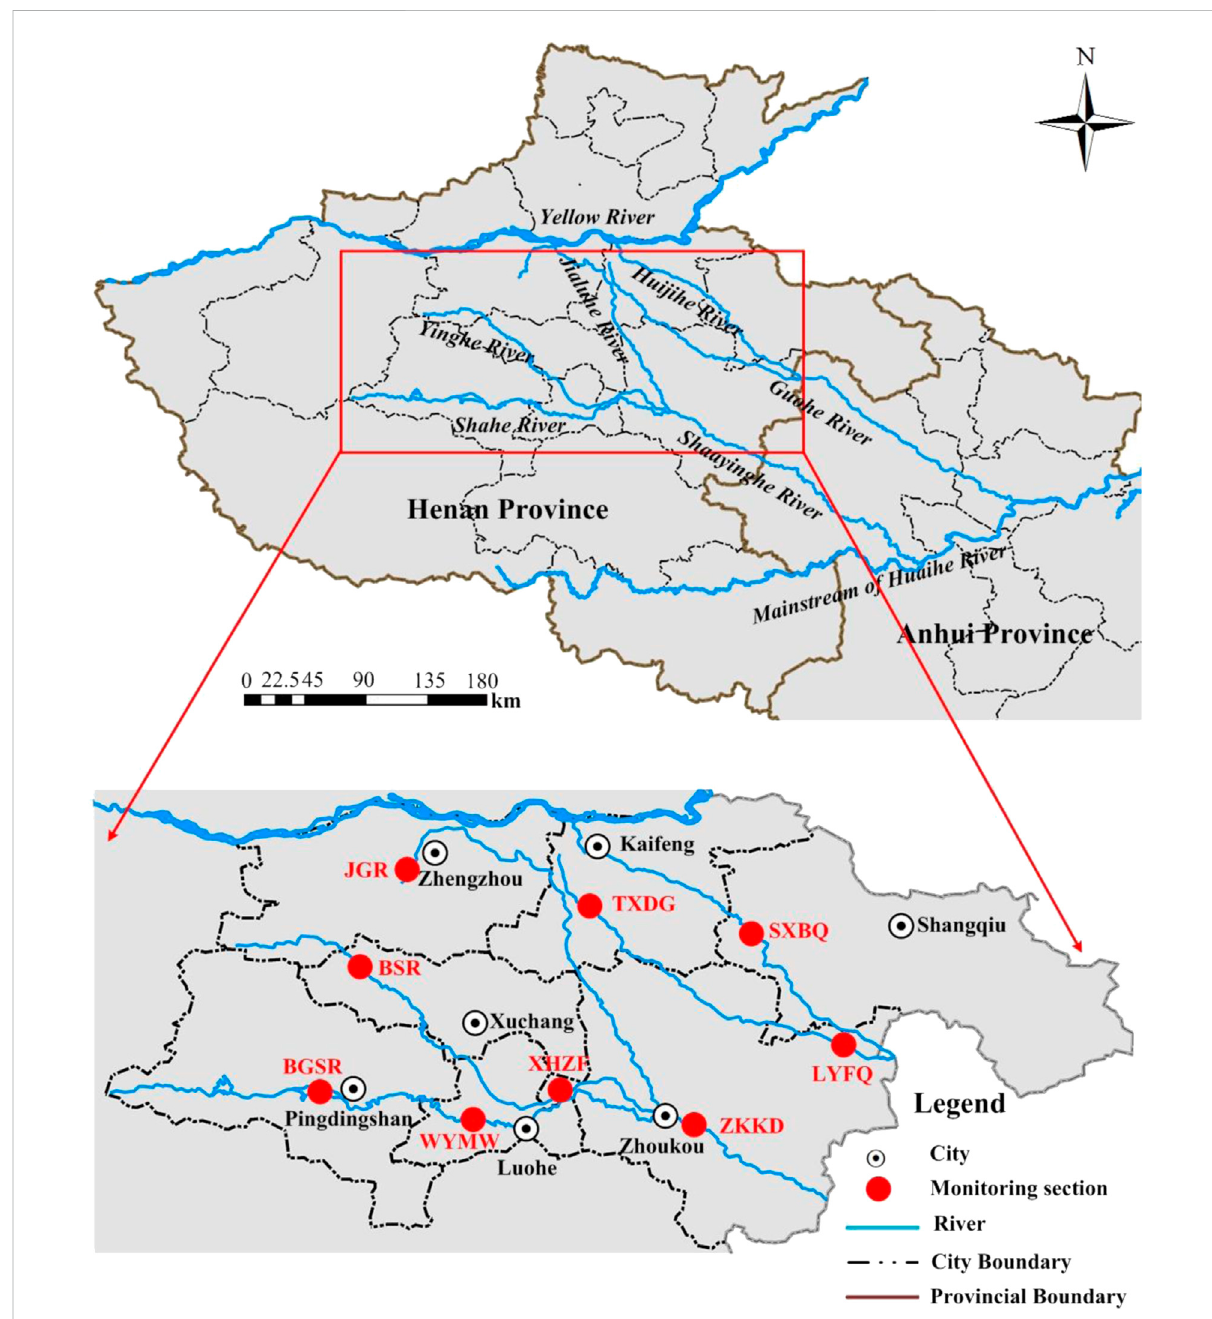
FIGURE 2 Water system map of the Huaihe River Basin in Henan Province and distribution of monitoring